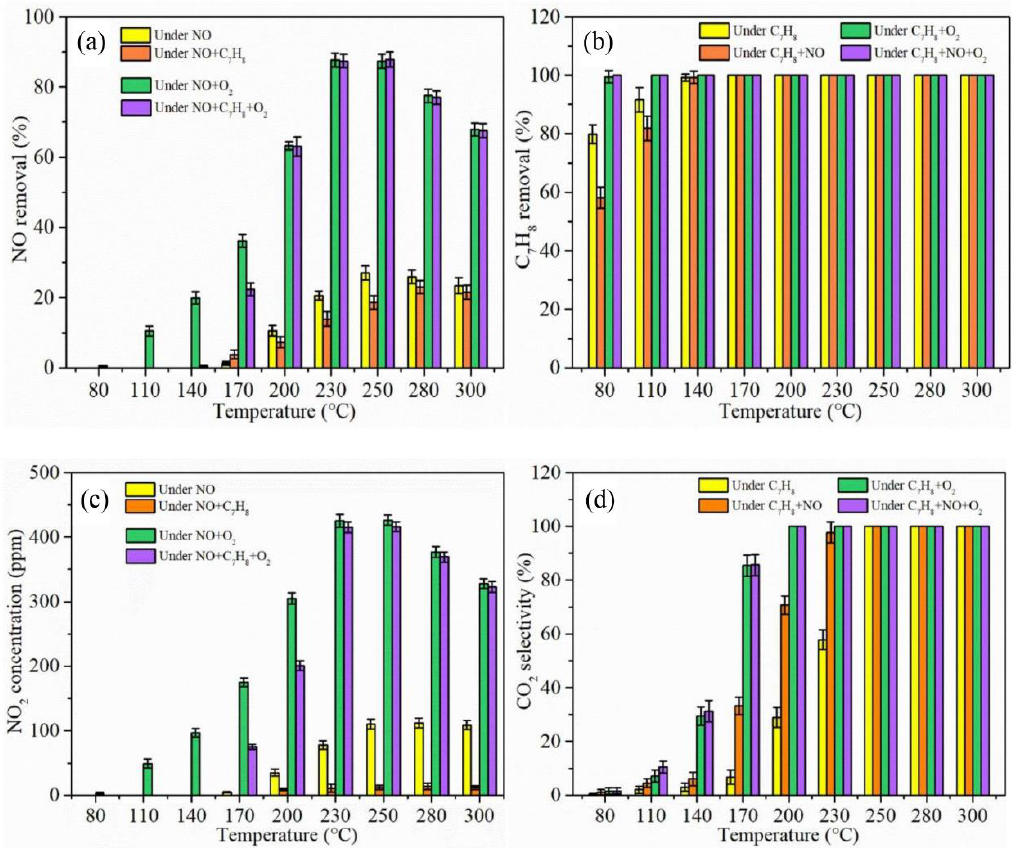
Figure 5. The NO removal ( a ), C 7 H 8 removal ( b ), NO 2 concentration ( c ), and CO 2 selectivity ( d ) after 100 min on Mn2Fe1 catalyst [111]. Reaction conditions: [NO] = 500 ppm, [C 7 H 8 ] = 50 ppm, [O 2 ] = 5 vol%, GHSV = 24,000 h − 1 , N 2 as balance gas. Copyright 2022, Elsevier B.V.